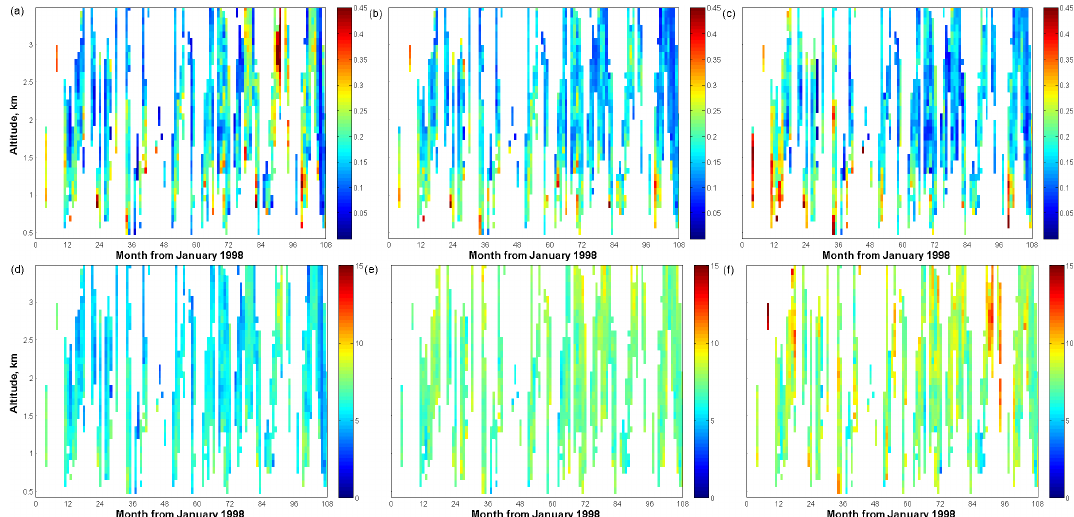
Fig. 7. Vertical profiles of monthly mean cloud LWC and r e for low-level non-raining non-mixed-phase stratus from the MICROBASE, UU, and UND products for the period of 1998 to